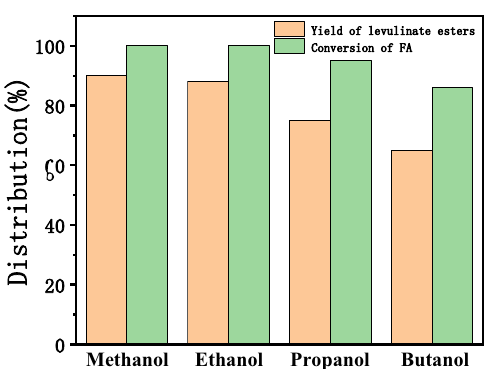
Figure 7: Yield of levulinate esters and conversion of FA with dif - ferent alcohol. Reaction conditions: catalyst 1.0 g, alcohol 20 mL, FA 2 mL, temperature 120°C, time 4 h, 300 rpm, and N 2